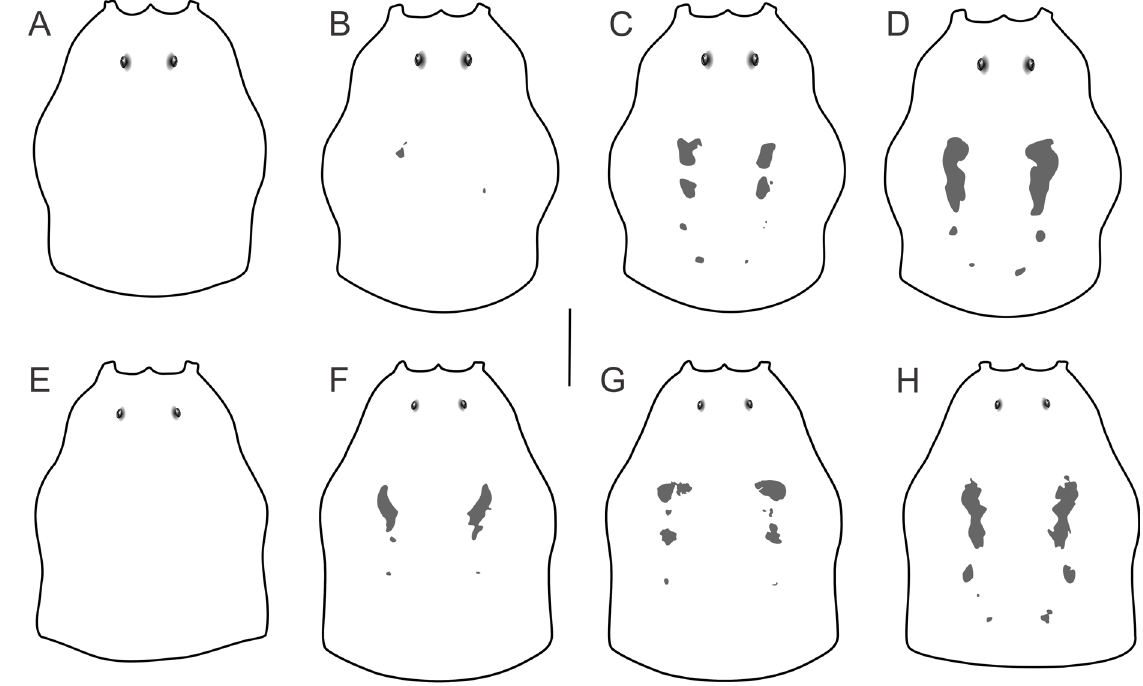
Fig. 2. Libitia bipunctata Sørensen, 1932, variation of spot pattern on dorsal scutum. A–D . ♂♂. A . IAvH-I-67. B . ICN-AO 468. C . ICN-AO 419. D . IAvH-I-87. E–H . ♀♀. E . IAvH-I-76. F–H . UNAL- AO 420. Scale bar = 1